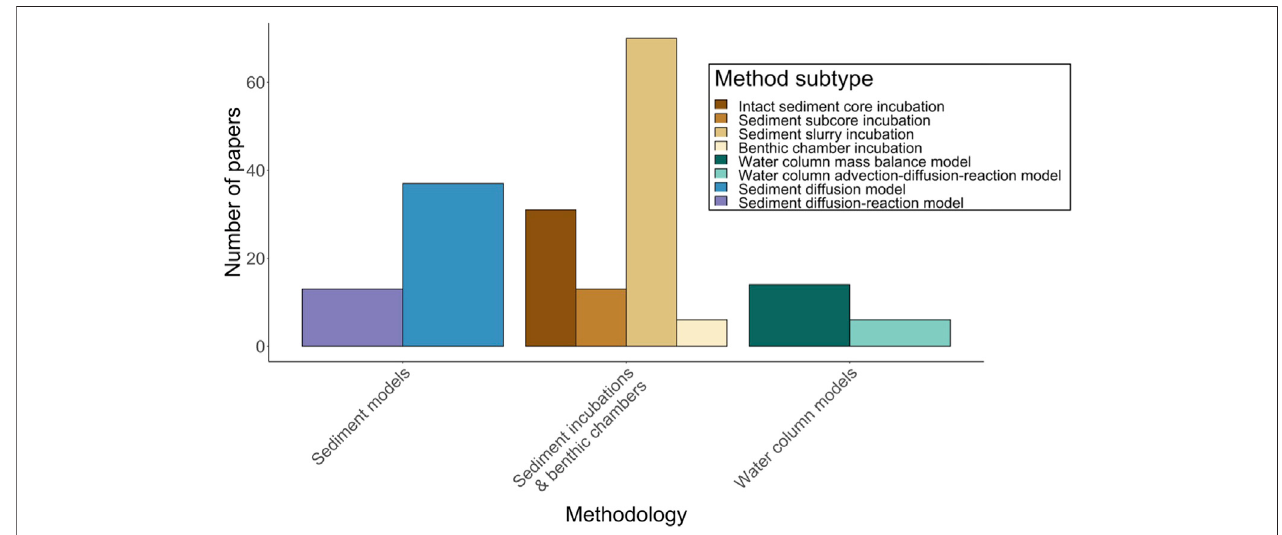
FIGURE 1 | Number of studies measuring sediment methanogenesis and/or the fl ux of CH 4 from sediments. Broad subcategories of methodology are shown in legend. Ten sediment incubation studies are excluded from the plot because incubation subtype could not be determined, however they are included in the Supplementary Data File of references ( Supplementary Table S1